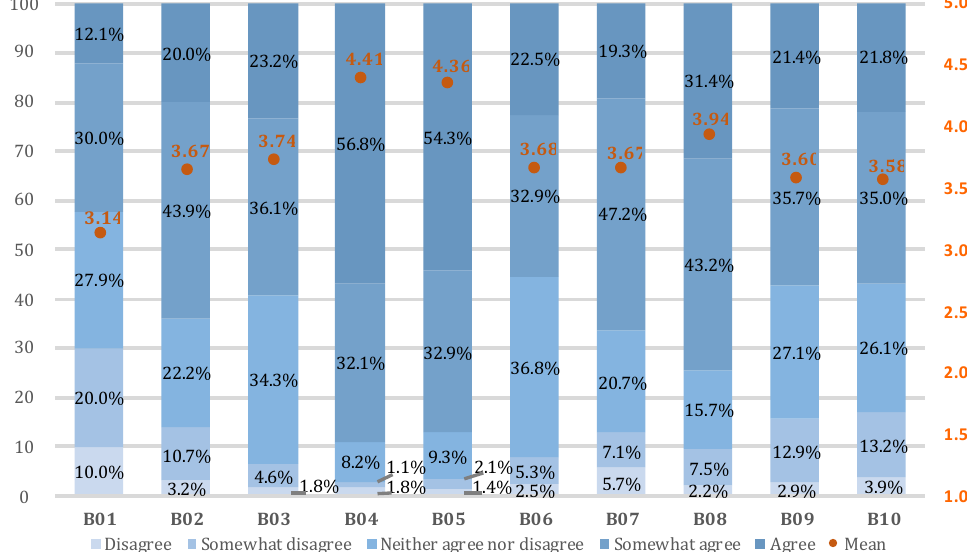
Figure 4. Opinions of the surveyed cities on the importance of barriers to the implementation of IEFS.